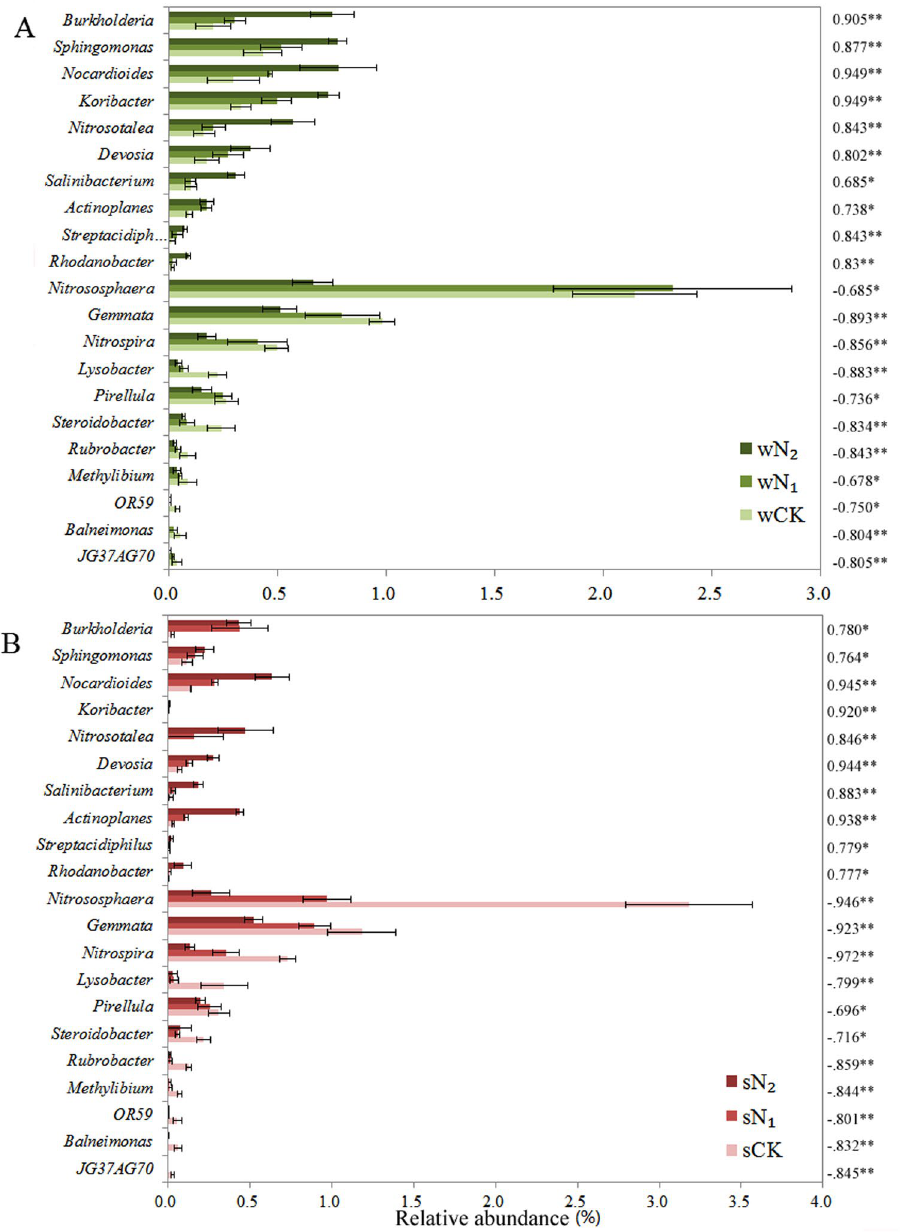
Figure 4. Changes in the relative abundances of bacterial genera across the N gradients in the wheat ( A ) and soybean ( B ) seasons. Only shown are those classes correlated with N added (Spearman’s r-values). Bars indicate one standard deviation. Asterisks show significant correlations ( ** P < 0.01, * P < 0.05). sCK, sN 1 and sN 2 indicate different N treatments in the soybean season; wCK, wN 1 and wN 2 indicate different N treatments in the wheat